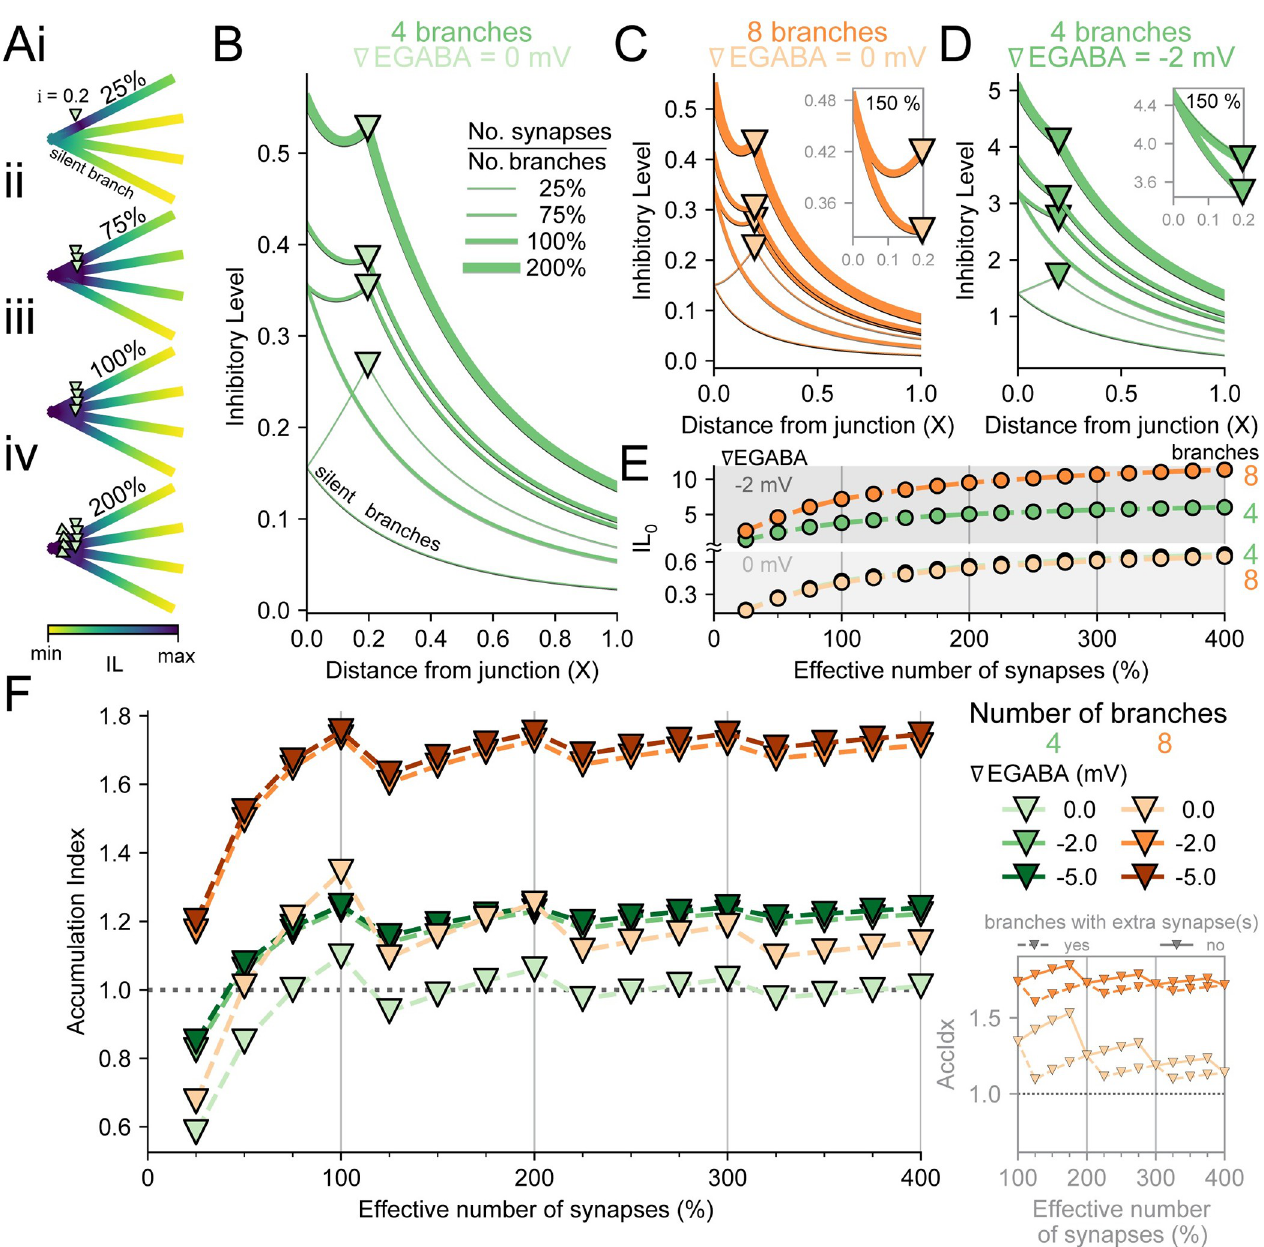
Fig 3. Increasing branch occupancy with inhibitory synapses enhances Inhibitory Level at the junction but saturates relative inhibitory accumulation. (A) The percentage of dendritic branches which have inhibitory synapses, “effective number of synapses”, indicates the diminishing return in additional IL when adding more synapses. (Ai-iv) 4 branch structure with 1 (Ai, 25%), 2 (Aii, 75%), 4 (Aiii, 100%), or 8 (Aiv, 200%) inhibitory synapses ( r EGABA = 0 mV). Note that inhibitory synapses are located at 0.2 X, so for 8 synapses on 4 branches (200%), there are 2 synapses per location. (B) IL as in ‘A’ for the effective (cid:0) � number of synapses number of synapses . Thinner lines indicate a lower effective number of synapses. Note that there is no “ r ” marker for branches without number of branches synapses, “silent branches”. (C) As in ‘B’ but with 8 branches. Thus, 75% effective number of synapses for 8 branches is 6 of the branches with synapses and the other 2 without synapses. Inset, 150% (12/8) effective number of synapses has some branches with a single synapse and others with 2 synapses. The branches with extra synapses have stronger IL values while the branches without extra synapses have a moderately better IL than 100% effective number of synapses. (D) As in ‘B’ and ‘C’, but the synapses on the 4 branches each have r EGABA = -2 mV. (E) The IL for shunting synapses (lower portion) and IL for hyperpolarising synapses (upper portion) at the junction for 4 and 8 branches with inhibitory synapses either at r EGABA = 0 mV or 2 mV. Line and marker colours same as in ‘F’. (F) Accumulation Index for different dendritic structures when varying the effective number of synapses. Regardless of r EGABA or number of branches, the AccIdx is maximised at 100% effective number of synapses. As in Fig 2, r EGABA < 0 mV is shifted from r EGABA = 0 mV. Note that the number of synapses is equal for 8 branches with 50% effective number of branches and 4 branches with 100% effective number of branches (4 synapses). Inset, the AccIdx for branches without extra synapses (short dashes) are greater than those with extra synapses (long dashes) because these branches utilise the boosted IL